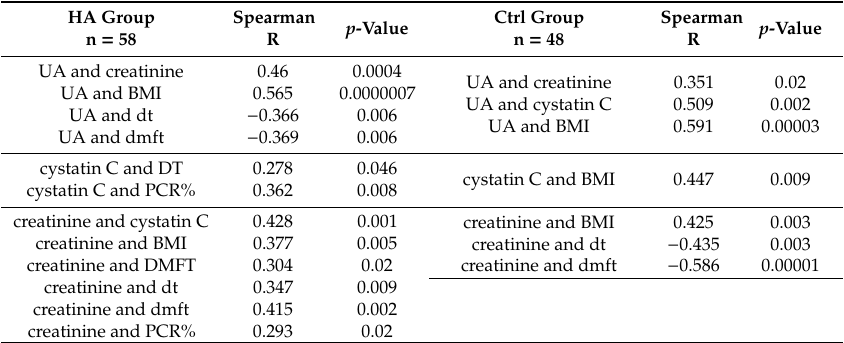
Table 2. Significant results of the Spearman’s correlation rank test regarding clinical and biochemical parameters ( p < 0.05) for the HA and Ctrl